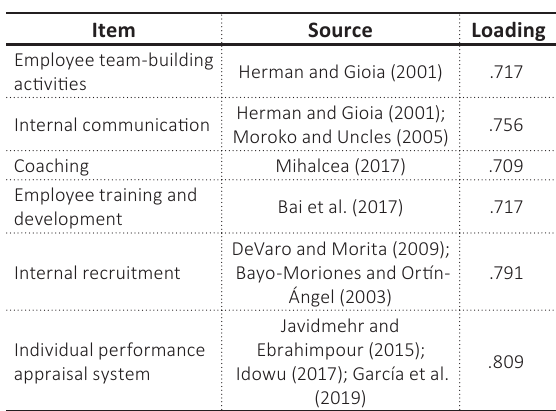
Table 1. Internal branding activities directed at